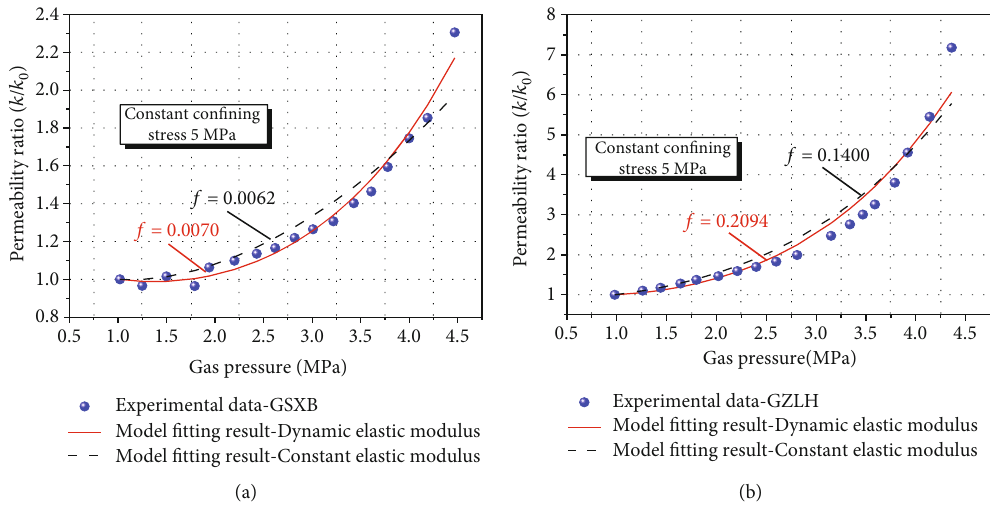
Figure 7: Matching results of the dynamic permeability model with laboratory test data under constant external stress conditions. Table 3: Parameters used for data matching under constant external stress